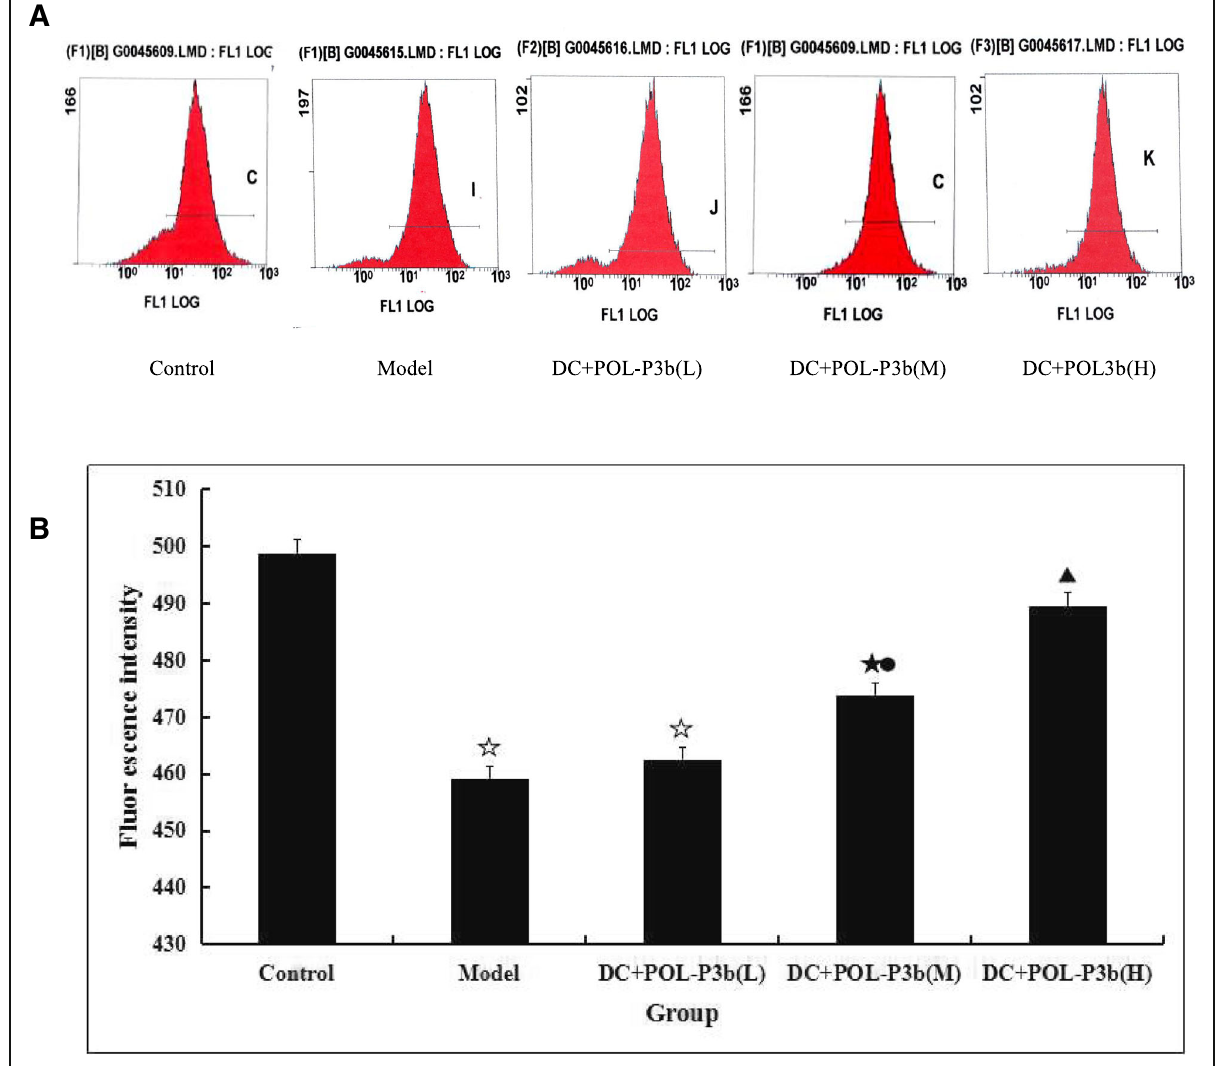
Fig. 2 Effect of POL-P3b on mitochondrial Ca 2+ of intestinal DC by oral administration a Mitochondrial Ca 2+ was analyzed using flow cytometry instrument. Data were collected in FSC (forward scatter) and SSC (side scatter) and a total of 10,000 events were collected for each sample. b The level of Ca 2+ was indicated with fluorescence intensity (I). The computation formula is as follows: I = Log (x-mode) × 340. Data were expressed as mean ± S.D. ( n = 10). compared with control, P < 0.05, ☆ P < 0.01; compared with model, ● P < 0.05, P <